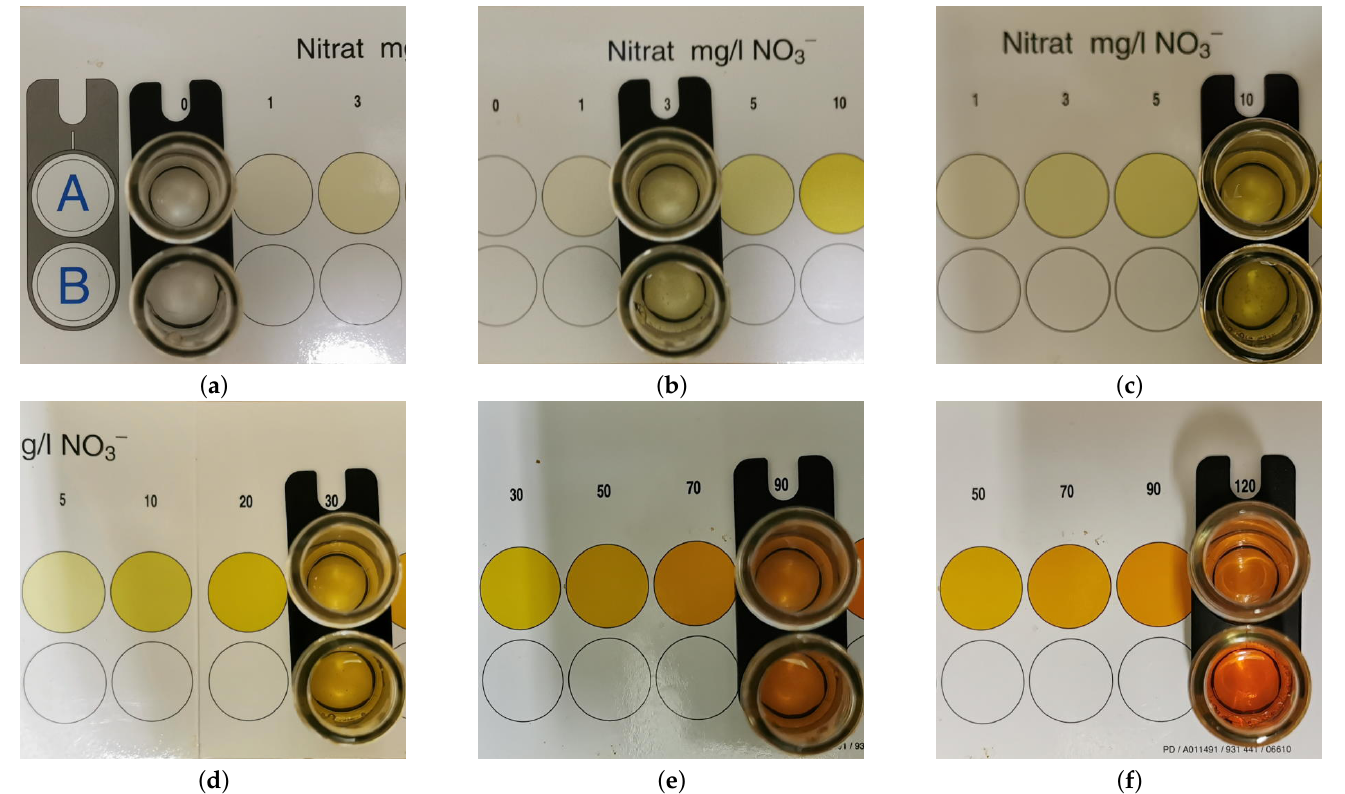
Figure 3. Validation of nitrate concentrations using a viscolor ECO colorimetric nitrate test. In each image, colour of bottom (coloured) test tube is matched with colour of scale underneath top (clear) test tube. ( a ) Distilled water. ( b ) 3mg/L solution. ( c ) 10mg/L solution. ( d ) 30mg/L solution. ( e ) 90mg/L solution. ( d ) 300mg/L solution, which exceeds range of test, as seen by bottom test tube being darker than 120mg/L